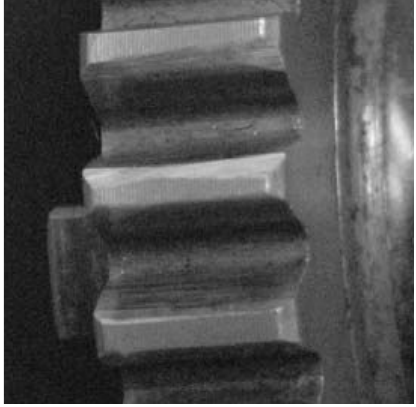
Fig. 3. B4 gear with 5% fault (5% eroded